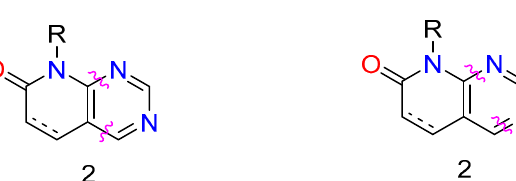
Figure 16. Synthetic approaches for pyrido[2,3- d ]pyrimidin-7(8 H )-ones ( 2 ) from a preformed pyridone.